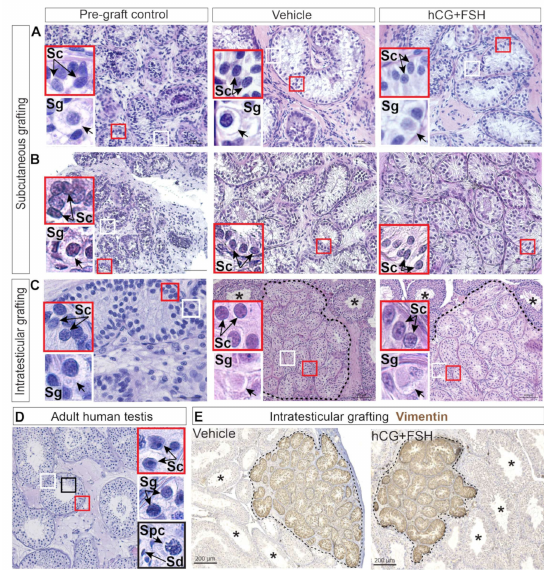
Figure 2. Haematoxylin and eosin staining and localisation of intratesticular prepubertal human testis grafts. ( A – C ) Histological examination of pre-graft controls ( A . 1-year-old, B . 5-year-old, and C . 14-year-old) and grafts revealed normal appearance of the interstitium and seminiferous cords. ( D ) Adult human testis. ( E ) Expression of Vimentin denotes vehicle and hCG + FSH-treated prepubertal human testis tissue transplanted intratesticularly. Dashed lines depict the outline of grafts transplanted into the mouse testis. Host mouse seminiferous tubules with complete spermatogenesis denoted by an asterisk (*). Insets show higher magnification of Sertoli and germ cells. Sc: Sertoli cell. Sg: spermatogonium. Spc: spermatocyte. Sd: spermatid. ( A – C ) Scale bars: 50 µ m, 100 µ m. ( D ) Scale bar: 100 µ m. ( E ) Scale bars: 200 µ